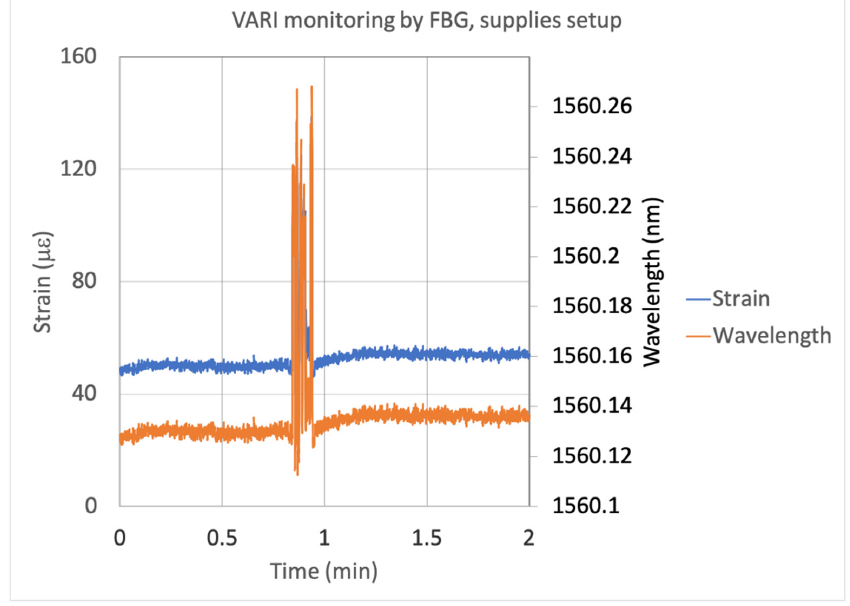
Figure 5. VARI monitoring by FBG, supplies setup with point loads to verify sensor sensitivity.